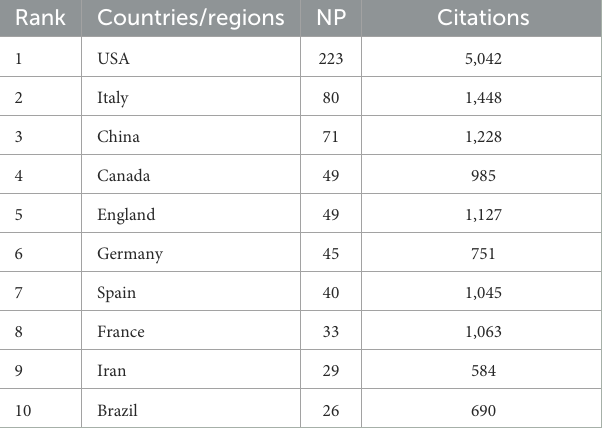
TABLE 2 Top 10 most prolific countries in COVID-19 and stroke research. Rank